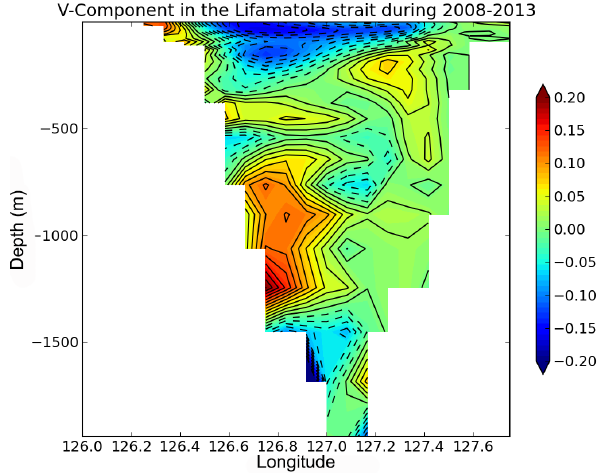
Figure 13. Mean of the along-strait velocity (ms − 1 ) in the Lifam- atola Strait (2008–2013). Contour (dashed lines) means a negative value (southward flow). Contour (solid lines) means a positive value (northward